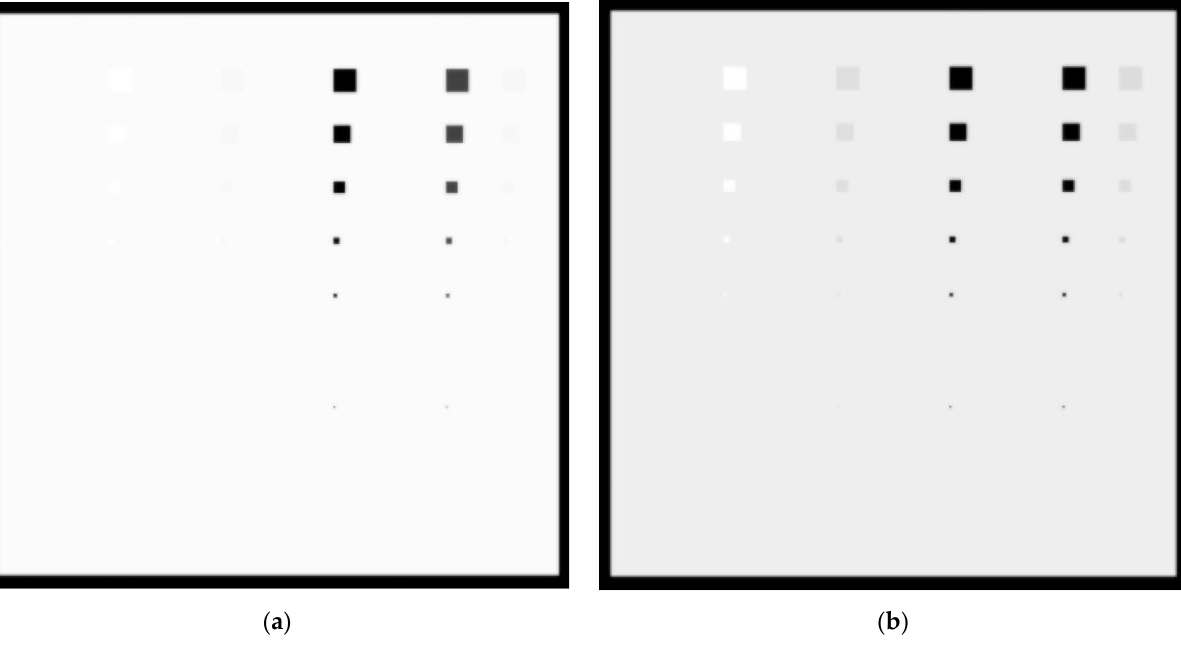
Figure 8. A 4.2 cm phantom image for W/Rh 5 mGy and 32 kVp spectrum with ( a ) 0.1 cm lesion thickness and ( b ) 0.5 cm lesion thickness.